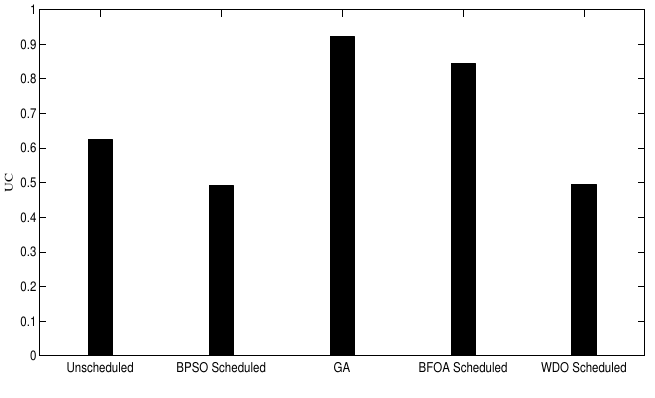
Figure 17. UC of GA, BPSO, WDO and BFOA.